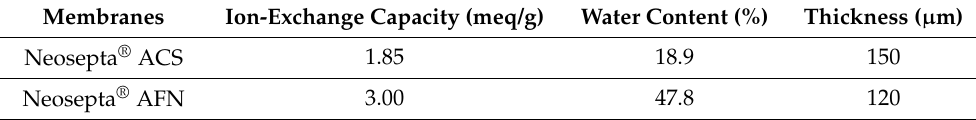
Table 1. Properties of the anion-exchange membrane used for the boron removal.